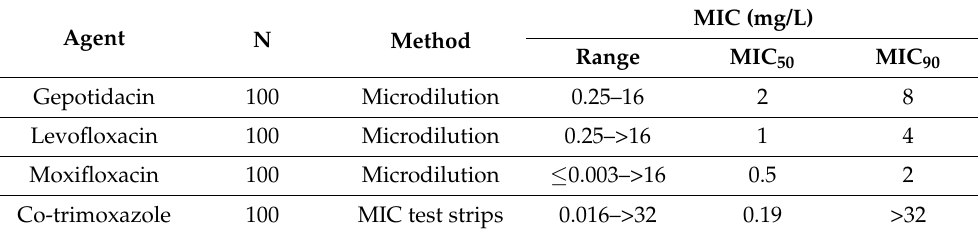
Table 1. Determined minimum inhibitory concentrations (MICs) of gepotidacin, levofloxacin, moxifloxacin, and co-trimoxazole against S. maltophilia . Agent N